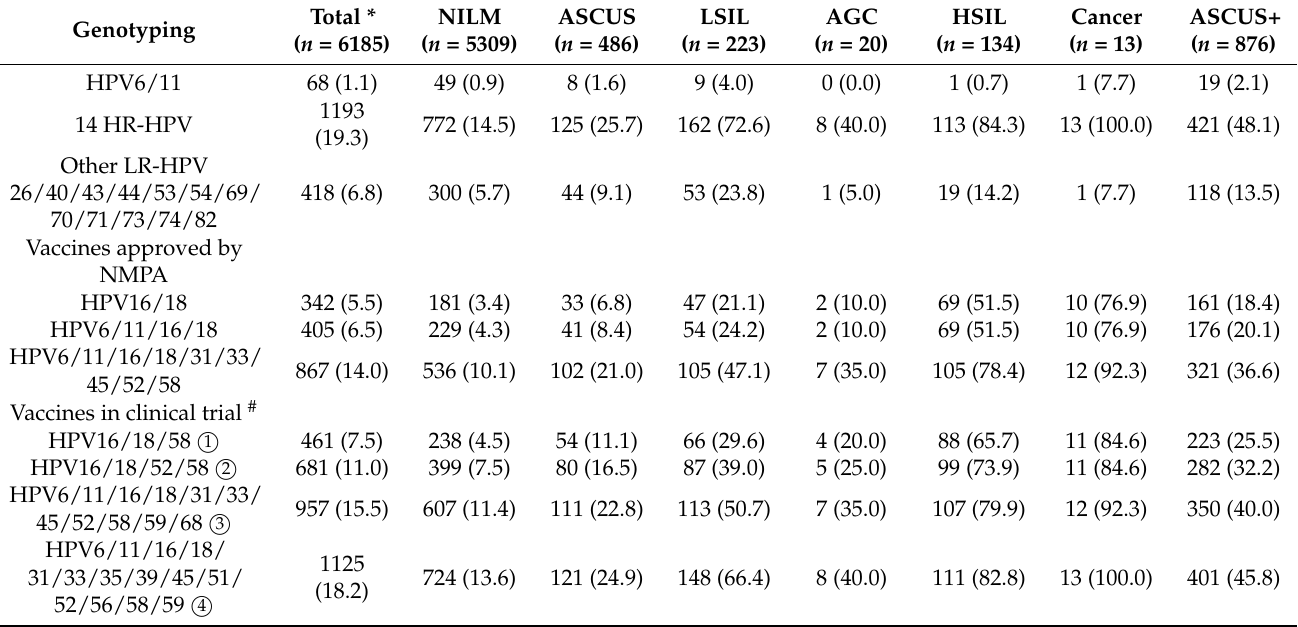
Table 4. The prevalence of different HPV type combinations in 6286 women, China, stratified by cytology n (%).